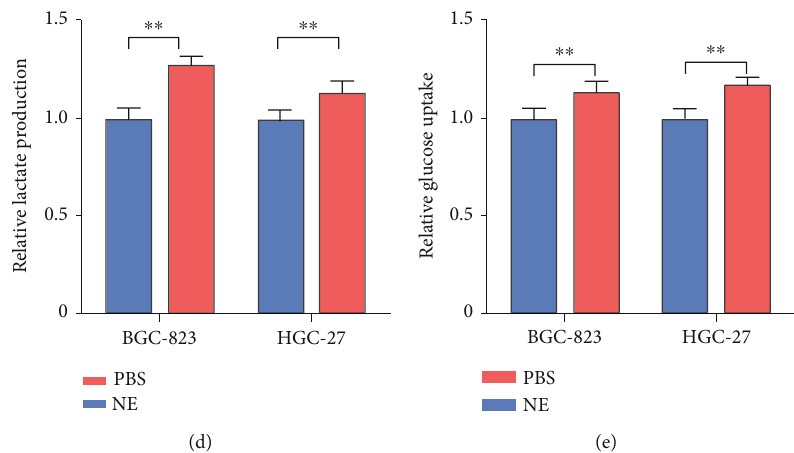
Figure 4: NE expression promotes tumor cell glycolysis. Regarding the gastric cancer cell line BGC-823, the Pkm, Pfkl, Ldha, Eno1, and Pgam2 mRNA expression levels were signi fi cantly elevated in the NE treatment group compared with the PBS treatment group. Regarding the other HGC-27 cancer cell line, the Pkm, Pfkl, Ldha, and Eno1 mRNA expression levels were signi fi cantly elevated in the NE treatment group compared with the PBS treatment group (a). After NE treatment, the EACR increased obviously for BGC-823 cells compared with PBS treatment. Regarding glycolysis and the glycolytic capacity, the NE and PBS treatment groups showed signi fi cant di ff erences (b). After NE treatment, the OCR decreased for BGC-823 cells compared with that after PBS treatment. Regarding ATP production and maximal respiration, the NE and PBS treatment groups showed signi fi cant di ff erences (c). In both BGC-823 and HGC-27 cells, lactate production and glucose uptake capability were more enhanced in the NE treatment group than in the PBS treatment group (d,